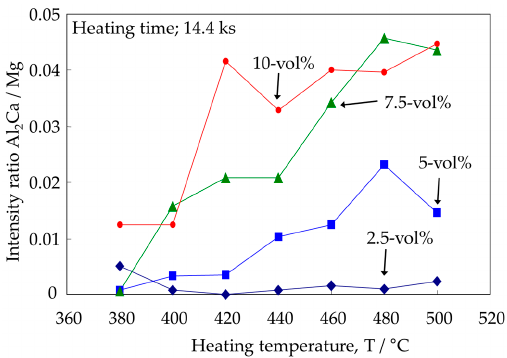
Figure 2. Dependence of X-ray diffraction (XRD) peak intensity ratio of Al 2 Ca and Mg peaks on heating temperature of AZ61B powder precursors with various contents of CaO particles.